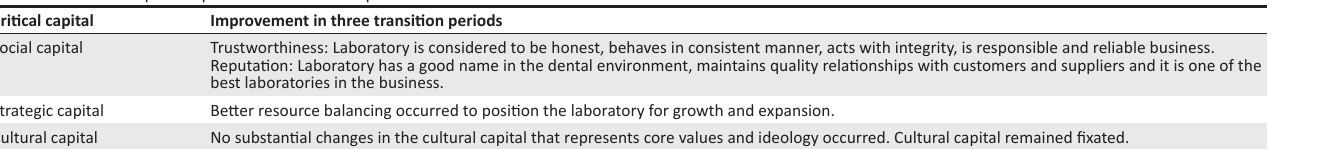
TABLE 2b: Critical capital improvements over